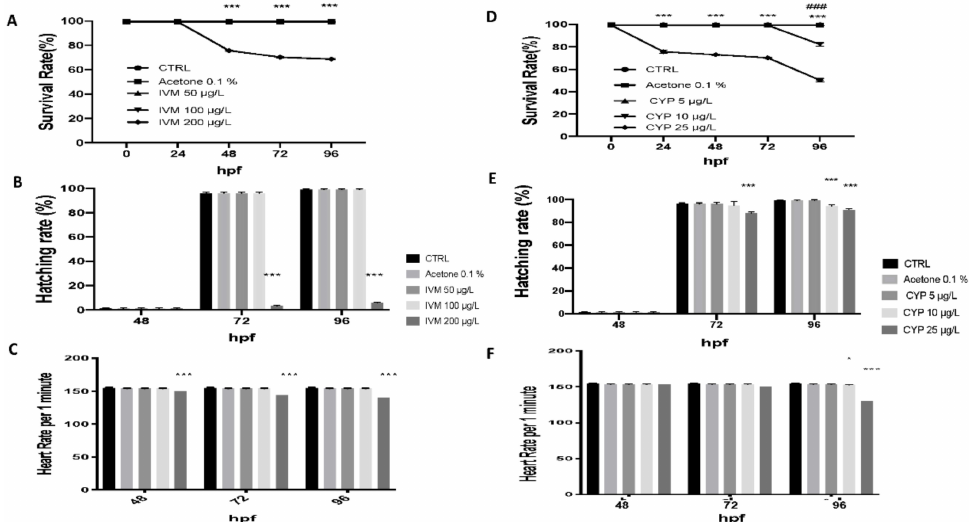
Figure 4. The survival hatching and heart rate of embryos exposed to different concentrations of IVM ( A – C ) and CYP ( D – F ), respectively, were determined at the designate time. Values = means ± SD of three independent experiment data: *** at p < 0.001 against CTRL. Photographs are representative of the experimental group’s situation ( n =